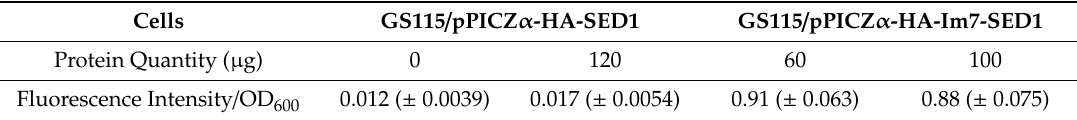
Figure 9. The fluorescence intensity/OD600 (F/A) values of yeast cells incubated with different amounts ( μ g) of CL7 ‐ sfGFP. Table 2. The fluorescence intensity / OD 600 (F / A) of sf-GFP on the yeast surface. Table 2. The fluorescence intensity/OD 600 (F/A) of sf ‐ GFP on the yeast surface. Cells GS115 / pPICZ α -HA-SED1 GS115 / pPICZ α -HA-Im7-SED1 Cells 0